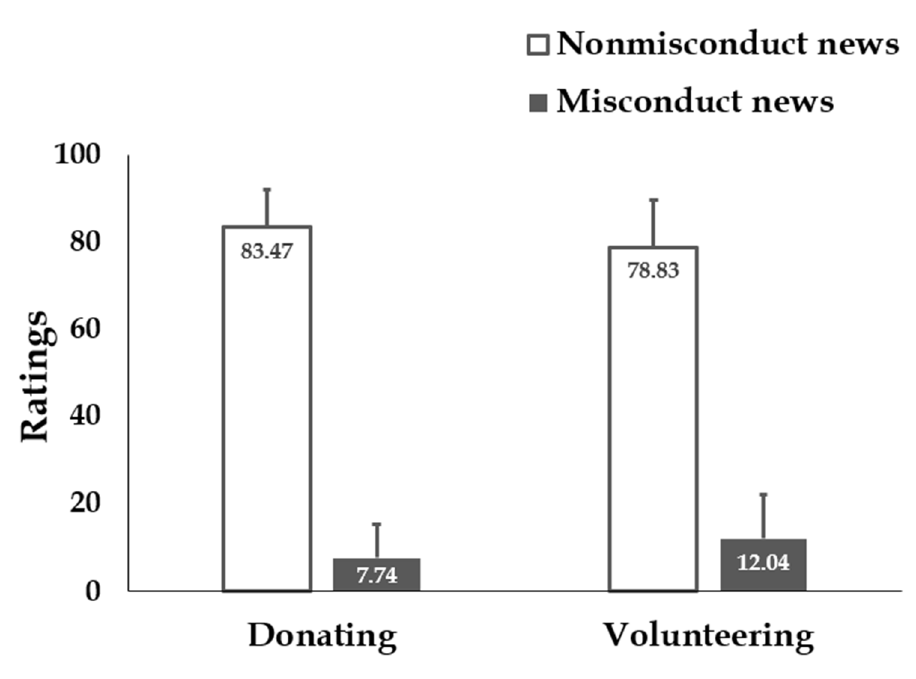
Figure 2. Results in Study 1. Participants’ willingness to donate to and volunteer at the misconduct charity was significantly lower than the nonmisconduct charity. Error bars: SD.